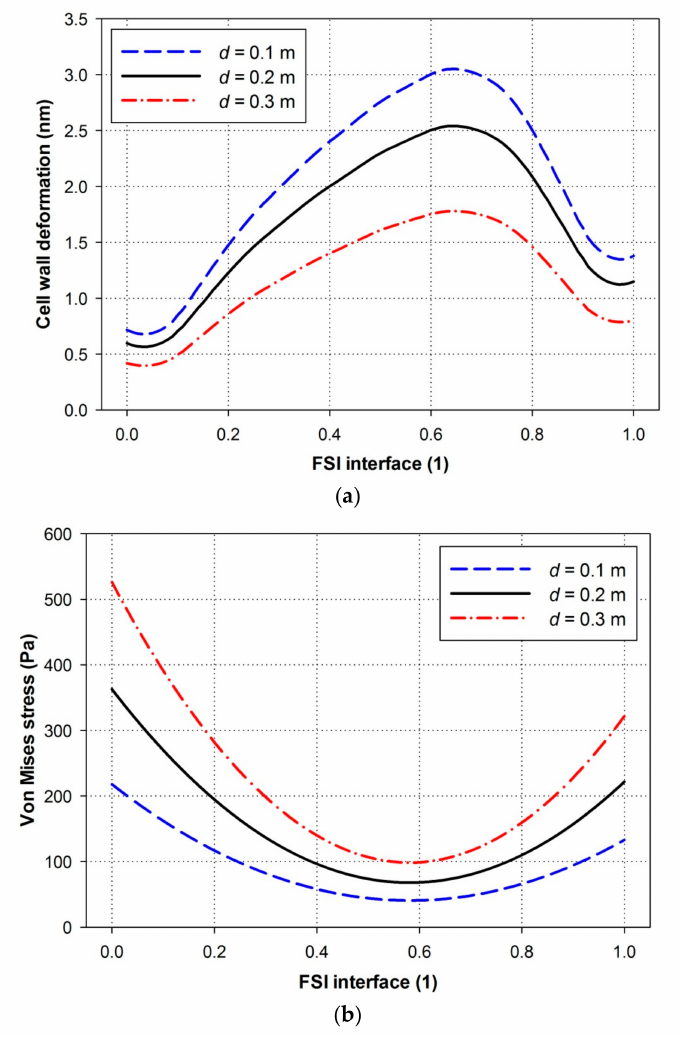
Figure 8. Effect of water depths on ( a ) cell wall deformation (nm) and ( b ) von Mises stress